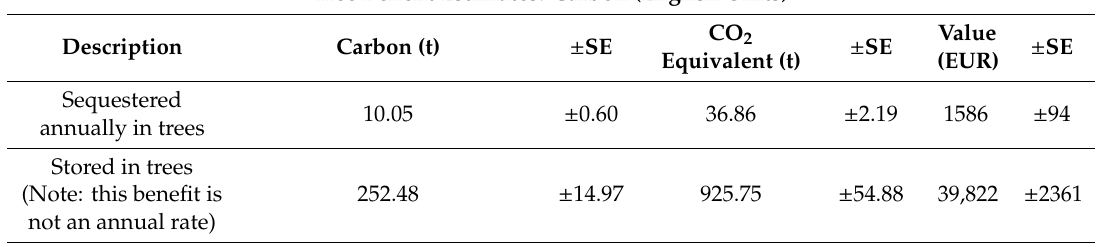
Table 2. Economic benefits of CO 2 storage (expressed in tons) and removal of air pollutants by trees (from i-Tree Canopy report).